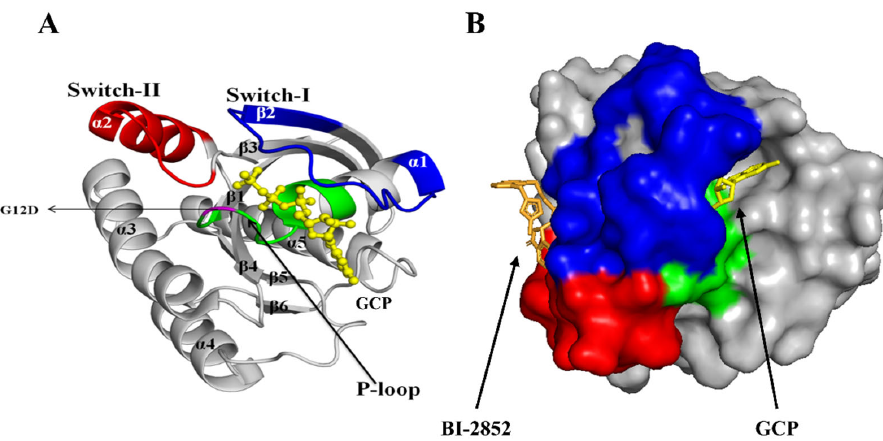
Figure 2. KRAS G12D mutant protein architecture: ( A ) A 3-D cartoon view of the GTP-bound KRAS G12D mutant protein (PBD ID: 6GJ8) was visualized, and its α -helices ( α 1, α 2, α 3, α 4, α 5), β -sheets ( β 1, β 2, β 3, β 4, β 5, β 6), switches (SI and SII) and P-loop are represented. The missense substitution mutation is present in the 12th position (in the P-loop) where the glycine (G) is substituted by aspartic acid (D). ( B ) Co-crystallized structure of phosphomethylphosphonic acid guanylate ester (GCP) (yellow) and BI-2852 (bright orange) in KRAS G12D mutant protein (PBD ID: 6GJ8). The P-loop (residues 10–17), switch I (residues 25–40), and switch II (residues 57–76) are shown in green, blue, and red, respectively. The SI/SII binding site of BI-2852 was selected for the molecular-docking studies.